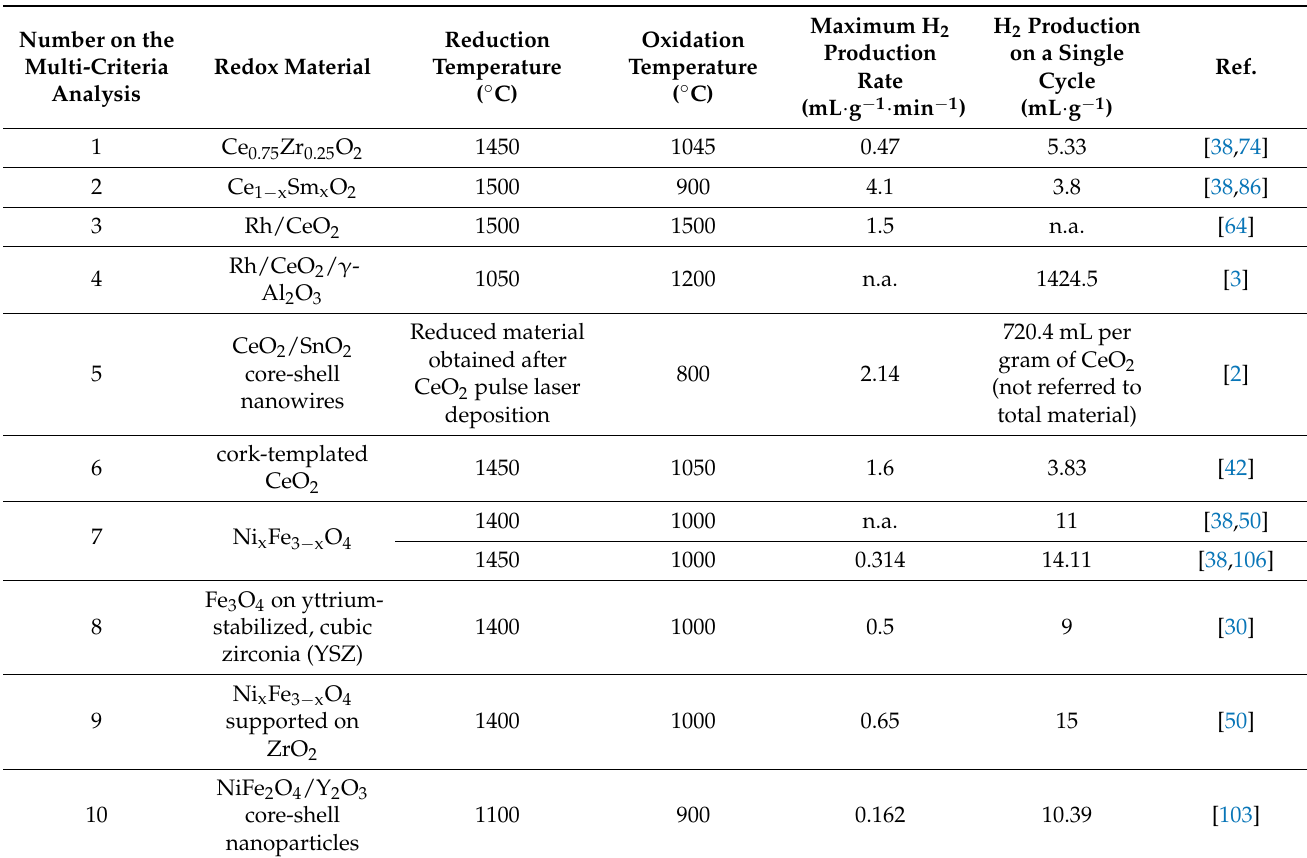
Table 2. Multi-criteria analysis including the criteria and weights of the redox materials suitable for thermochemical two-step water